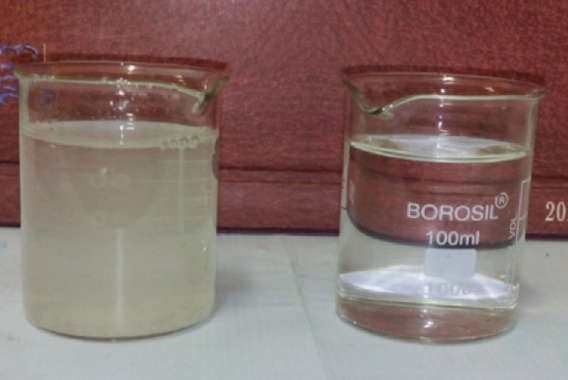
Fig. 4 Synthetic water before and after filtration